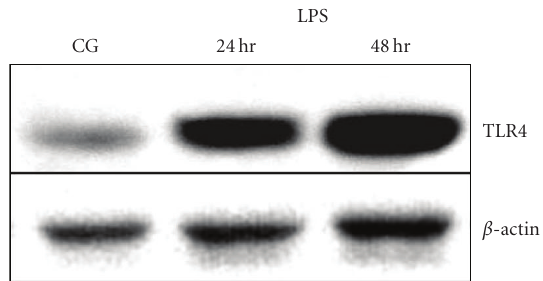
Figure 2: mRNA expression of TLR4 in AM Φ by RT-PCR. A repre- sentative agarose gel electrophoresis showing PCR amplification of TLR4 and β -actin from cultured AM Φ with control group and LPS group (at 24, 48